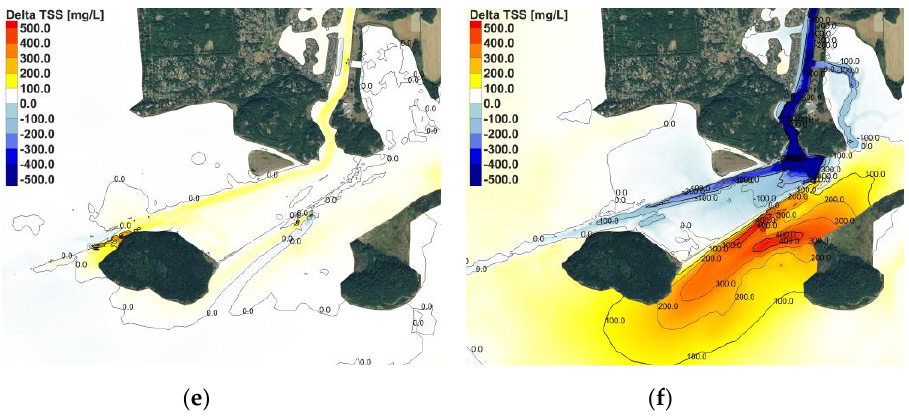
Figure 16. Time averaged horizontal distribution difference between baseline conditions and SCN-1 for ( a ) salinity ( c ) shear stress and ( e ) TSS; time averaged horizontal distribution difference between baseline conditions and SCN-2 for ( b ) salinity ( d ) shear stress and ( f ) TSS. The positive sign of the color bar means that the baseline concentrations are higher than the selected scenario.